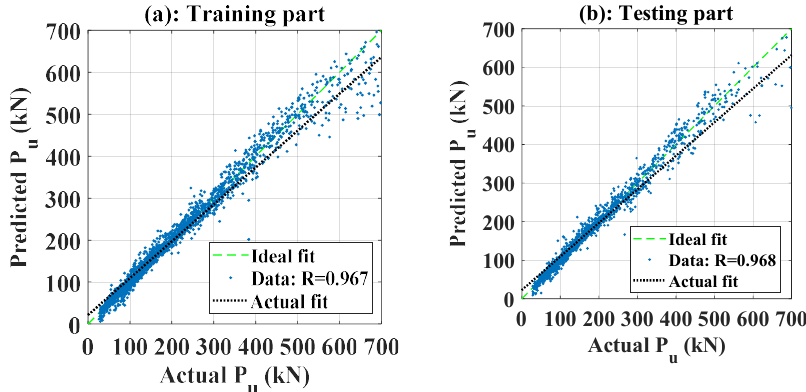
Figure 14. Graphs of regression plots between actual and predicted P u (kN) for the ( a ) training part and ( b ) testing part.